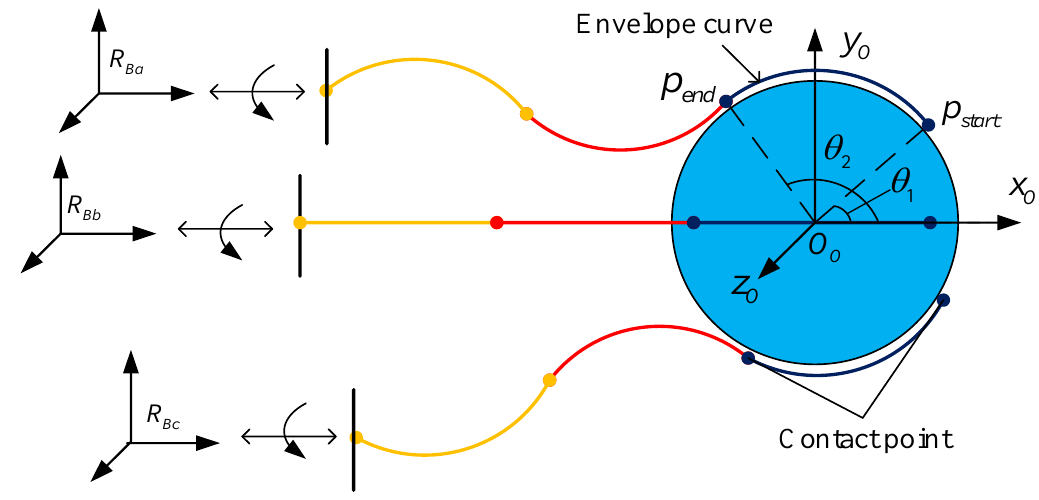
Figure 13. Schematic of the envelope grasping of the multi-arm space robot.